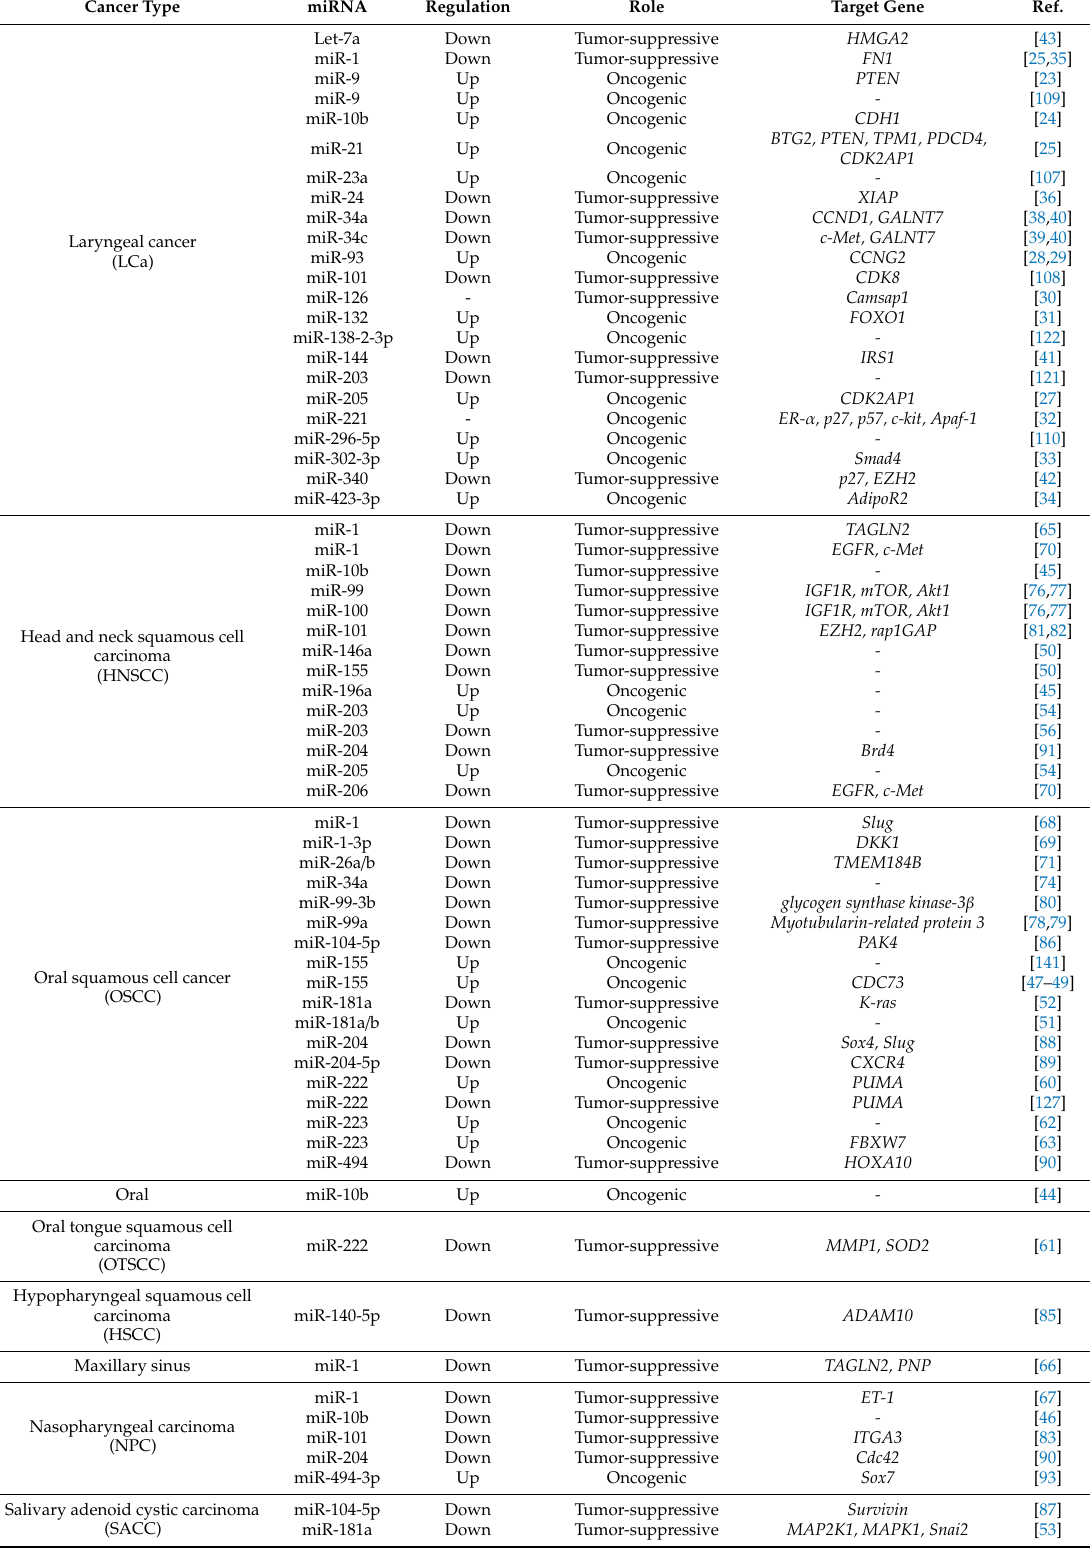
Table 1. miRNA deregulation in head and neck cancer and validated